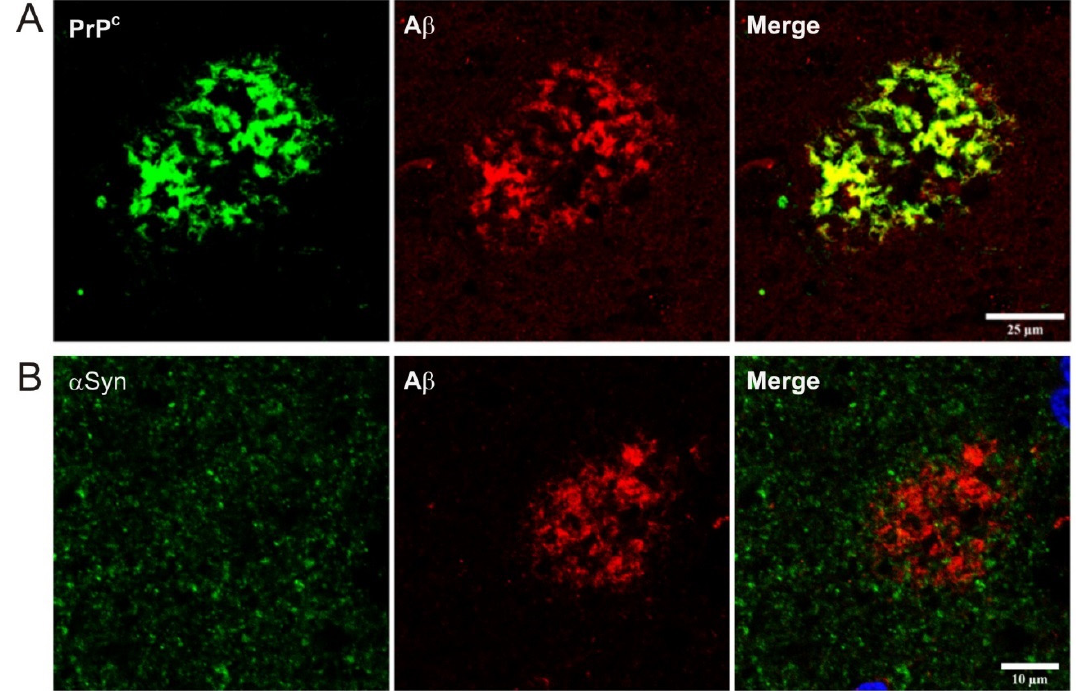
Figure 1. Confocal images of self-aggregative proteins in AD patients. ( A ) Double-labeling immunofluorescence of PrP C (clone 3F4 directed against aa 109–112 of prion protein, Merck Millipore) and A β (rabbit polyclonal antibody directed against the N-terminus 11-pyro E start point of human beta-amyloid, Novus Biologicals) showing colocalization of PrP C in A β deposits. ( B ) Double-labeling immunofluorescence of α -synuclein (clone 5C2 raised against recombinant alpha-synuclein aa 61–95 purified from E. coli , Labome) and A β (Novus). Note the absence of clear colocalization between these two proteins. Scale bar values are displayed in the Merge